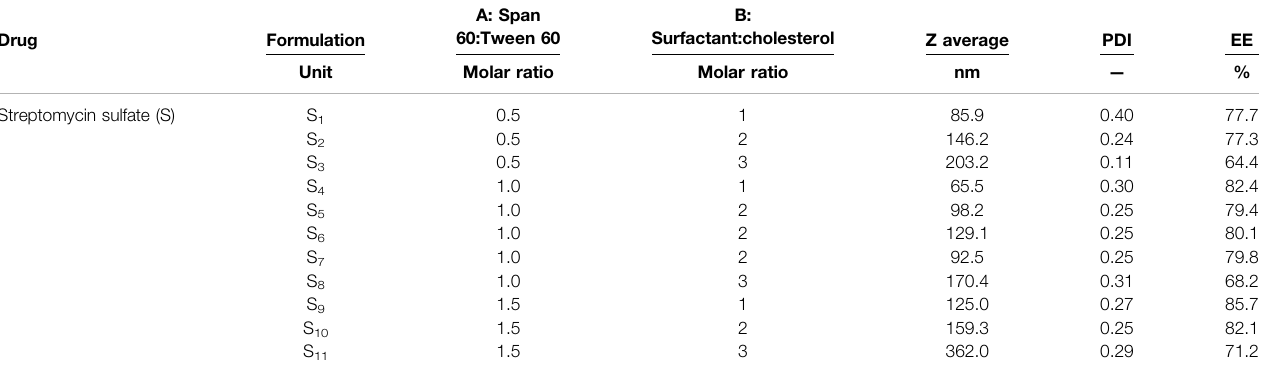
TABLE 1 | Composition of different formulations of